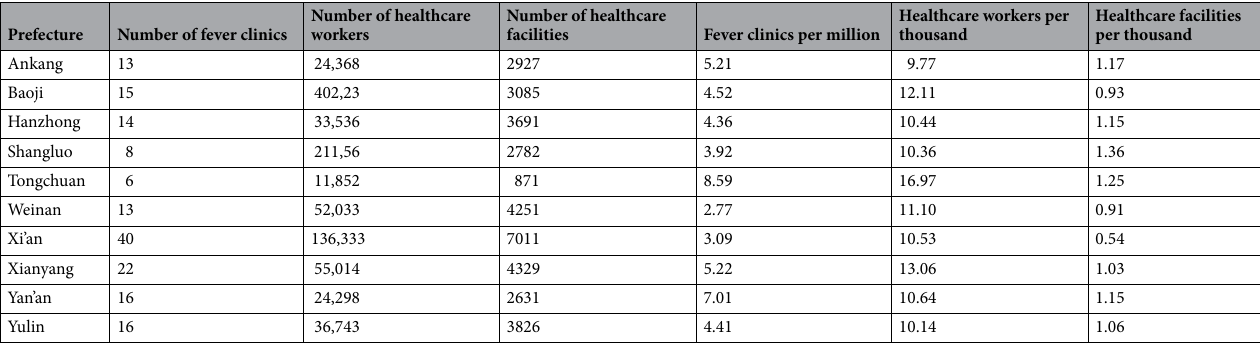
Table 4. Geographic distribution of medical resources. Statistics of fever clinics are extracted from published documents by Shaanxi Health Commission and statistics of healthcare workers and healthcare facilities are obtained from the Shaanxi Statistic Yearbook in